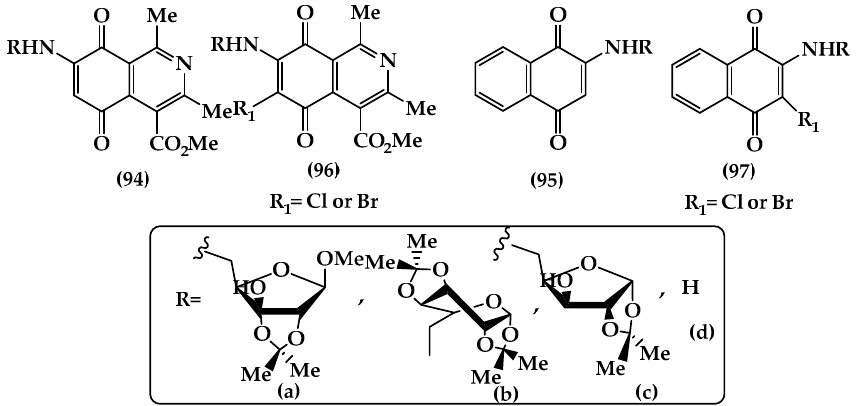
Figure 14. Structures of amino sugar-based isoquinoline-5,8-diones ( 94 ) and naphthoquinones ( 95 ) and their halogenated compounds, ( 96 ) and ( 97 ).